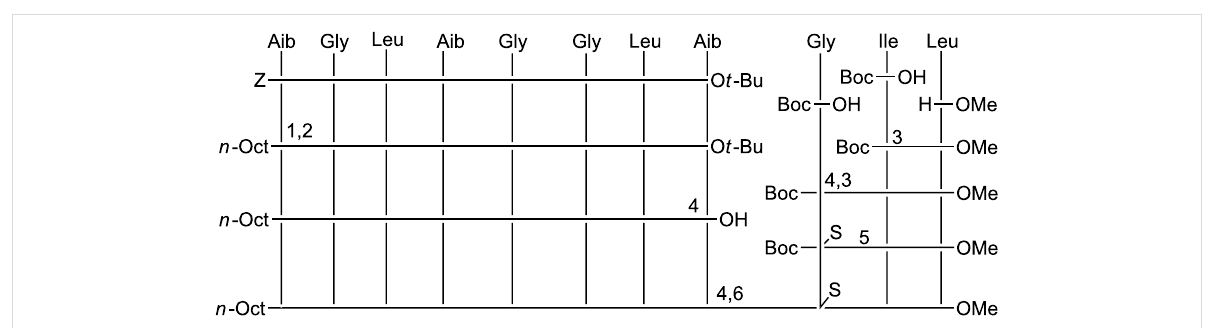
Scheme 3: Synthesis of ψ [CS-NH] 9 . 1: Deprotection by catalytic hydrogenation with Pd/C. 2: Coupling with n -Oct-OH in the presence of EDC/HOBt. 3: Coupling in the presence of EDC/HOBt. 4: Deprotection by using TFA/DCM. 5: Thionation with Lawesson's reagent in THF. 6: Coupling in the pres- ence of